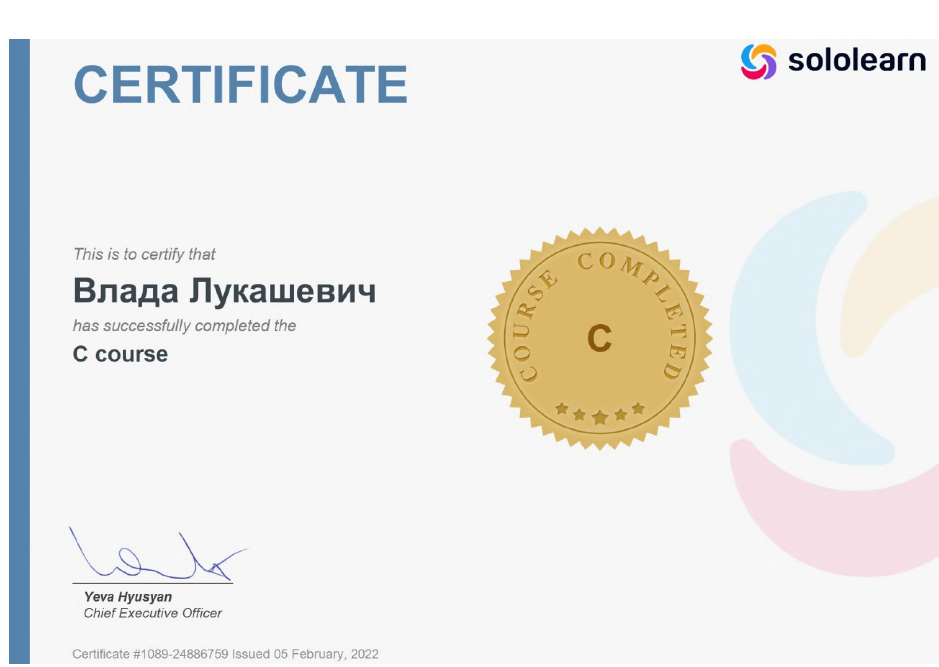
Figure 9: Course completion scale.